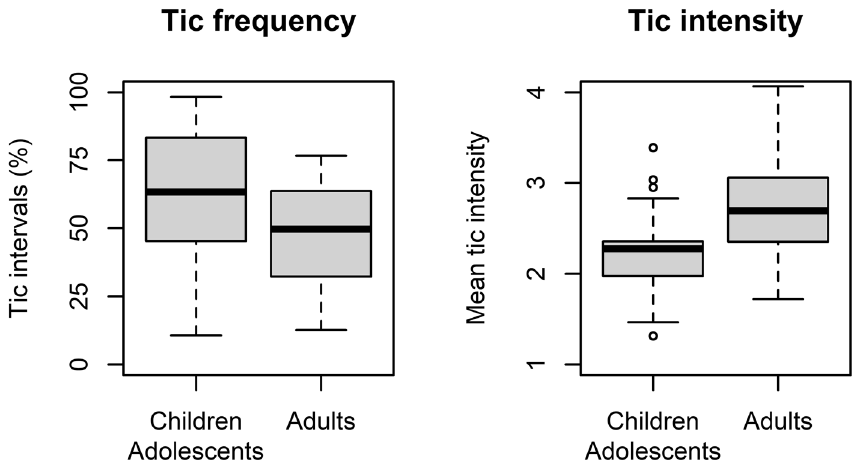
Figure 4. Comparison between age groups for tic-related measures from the urge monitor. Boxes indicate inter- quartile range and median, whiskers extend to values up to 1.5 IQR beyond first and third quartile, respectively. Values outside this range are shown as individual points.